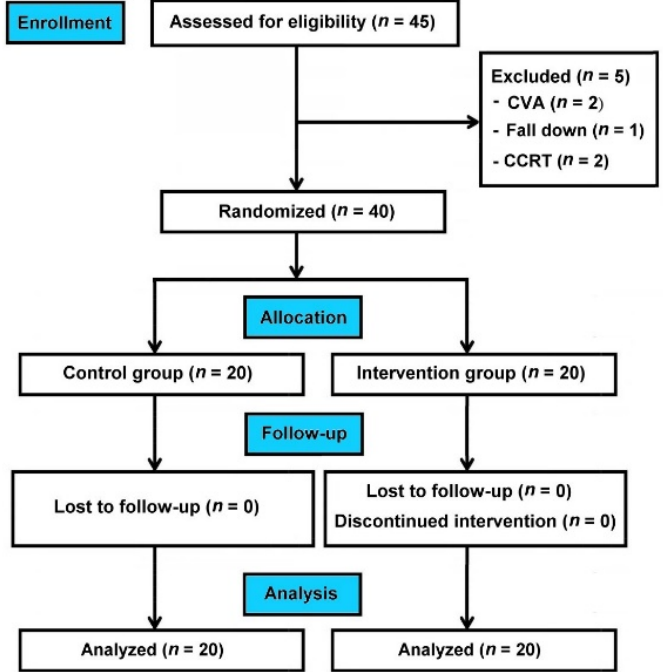
Figure 1. CONSORT flow diagram. CONSORT, Consolidated Standards of Reporting Trials; CVA, cerebrovascular accident; CCRT, concurrent chemoradiotherapy. Table 1. Comparison of baseline demographic data and clinical characteristics between the control and intervention groups. Total Control Intervention p- Value Variables ( n = 40)